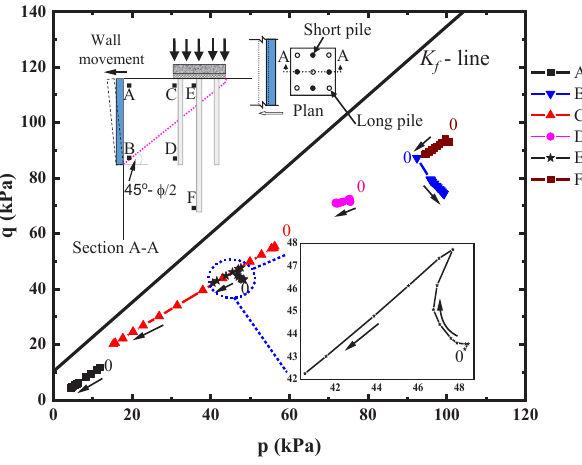
Figure 5: Soil stress paths at different observation points for nine long–short pile composite foundation located at 3 m away from the wall (0 indicates the stress state before wall rotation)